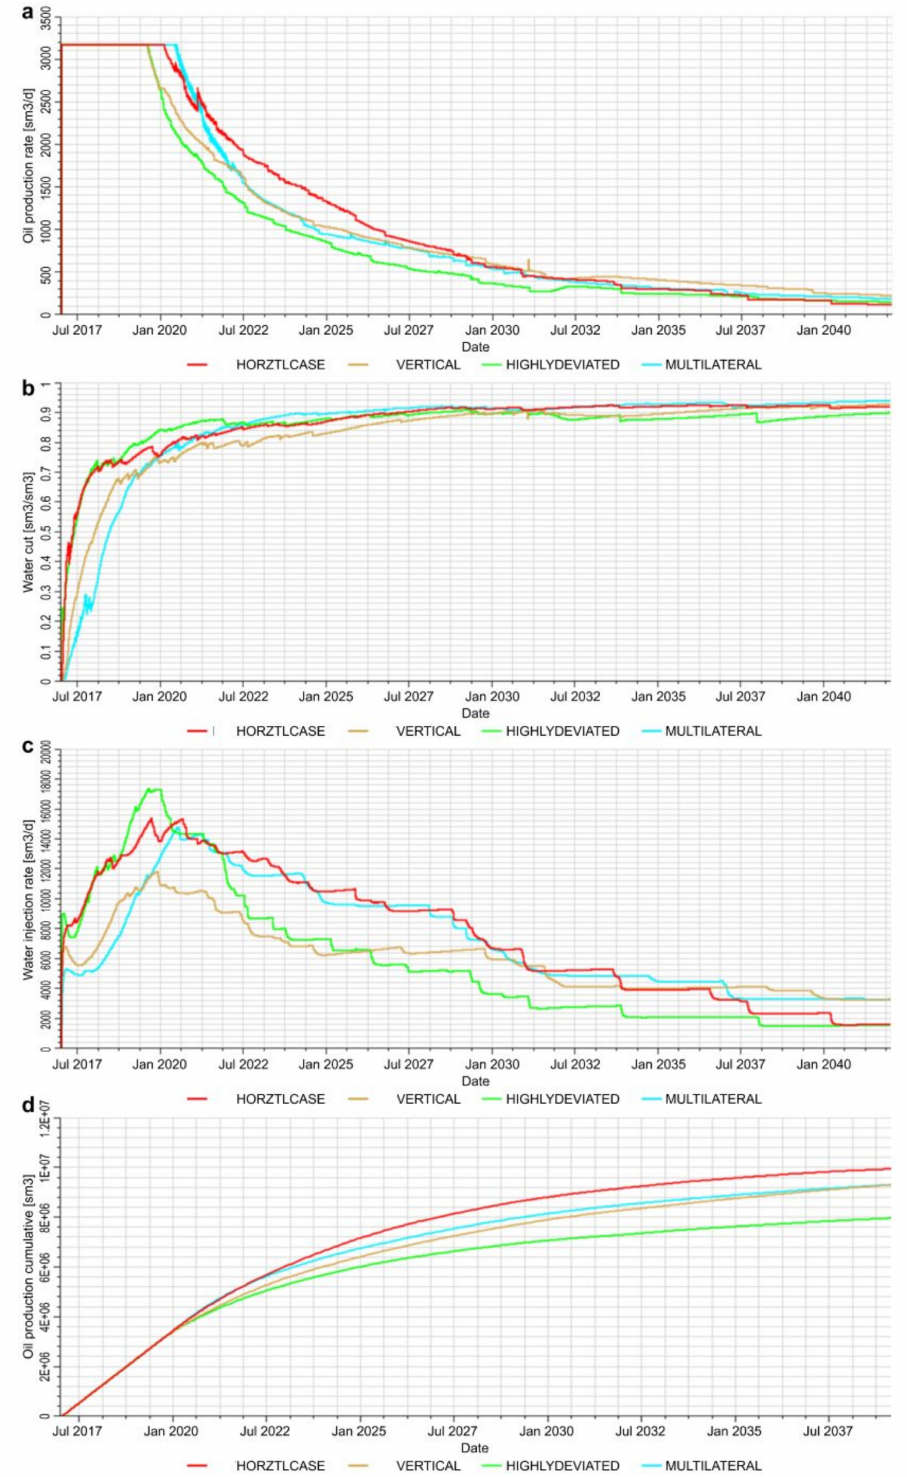
Figure 11. Production profile plots for the individual properties of each well type. ( a ) Oil production rate of each well type, ( b ) field water-cut ratio profiles of each well type, ( c ) field water injection rate profiles of each well type, and ( d ) field cumulative oil production of each well